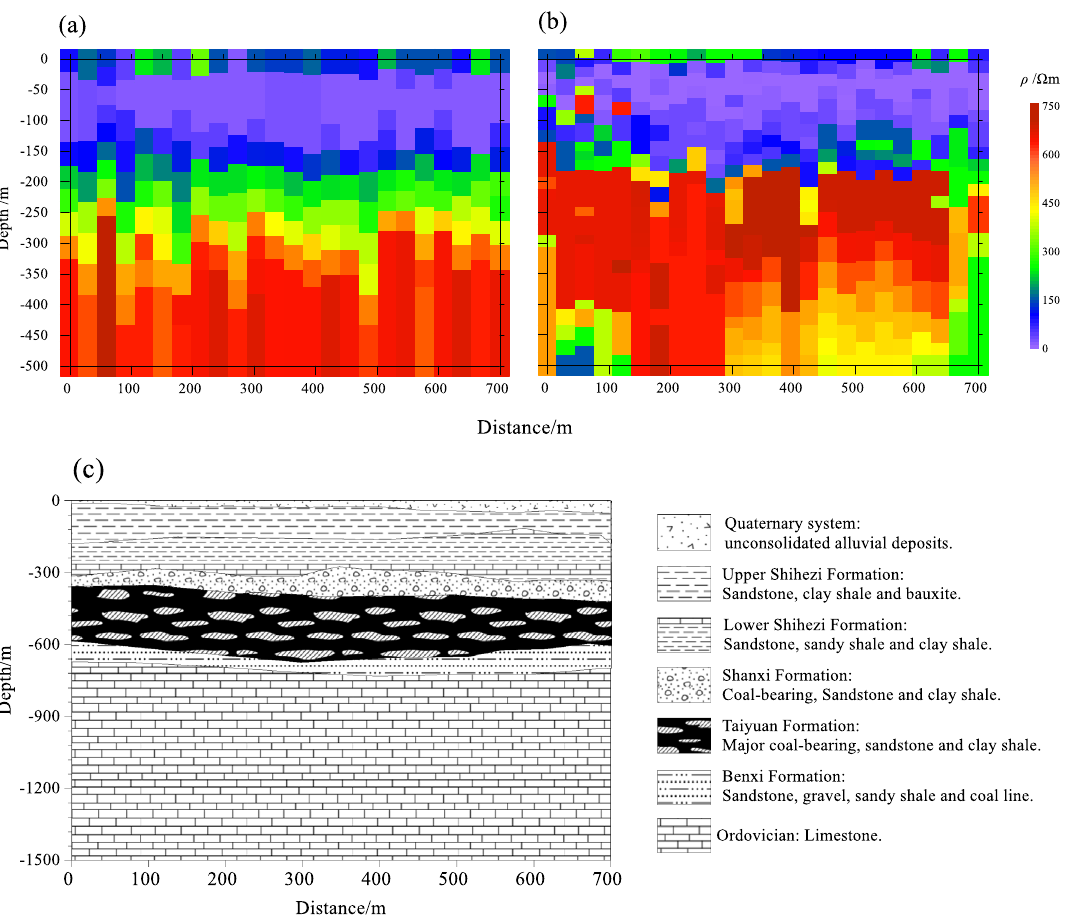
Fig. 9 Comparison of a maximum-probability results of Bayesian MCMC and b Occam’s inversion along the survey line with a c schematic geological profile based on local geology survey report